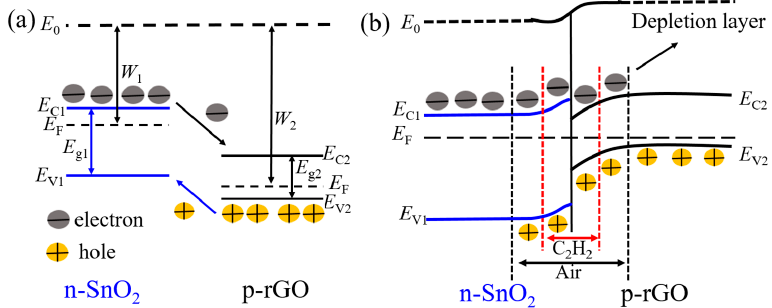
Figure 12. Schematic of the energy band diagram and the variation in depletion layer thickness for the SnO 2 /rGO heterojunction. ( E C , conductor band; E g , band gap; E V , valence band; E F , Fermi level; W, work function)